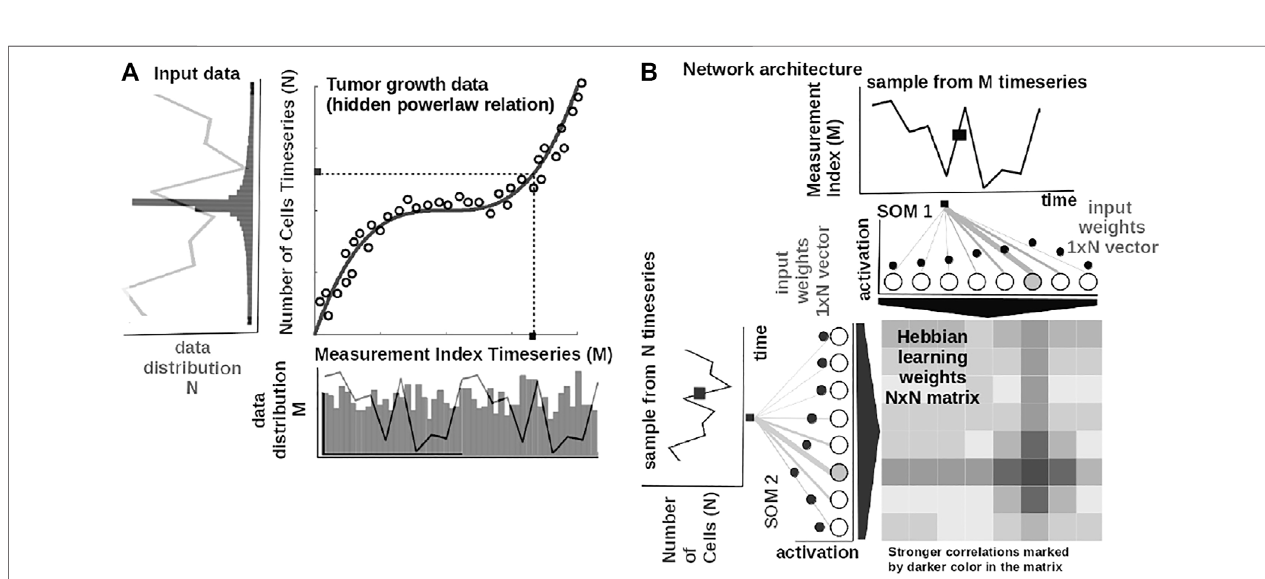
FIGURE 2 | Basic functionality of the system. (A) Tumor growth data following a nonlinear mathematical relation and its distribution — relation is hidden in the time series (i.e., number of cells vs. measurement index). Data from Comen et al. (2016). (B) Basic architecture of our system: one-dimensional (array) SOM networks with N neurons encoding the time series (i.e., number of cells vs. measurement index), and an N × N Hebbian connection matrix (coupling the two SOMs) that will encode the mathematical relation after training.